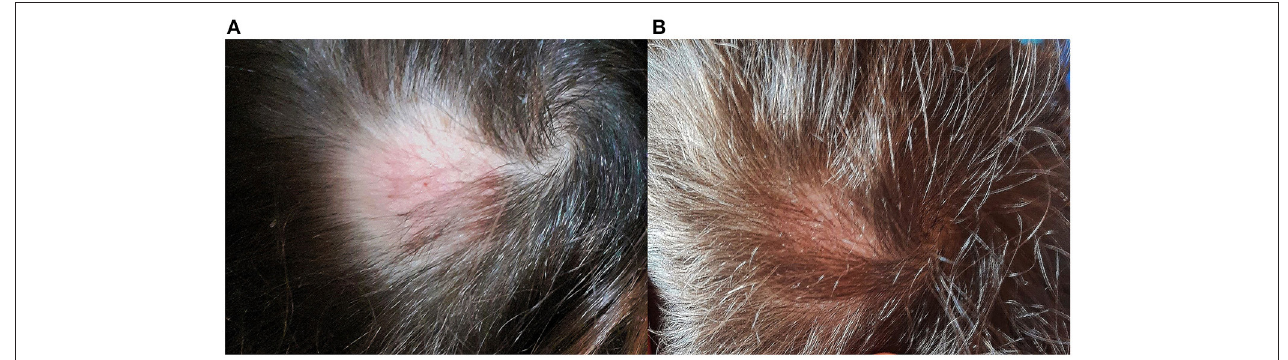
FIGURE 3 | Clinical course. (A) Three months and (B) 4 months after initiation of